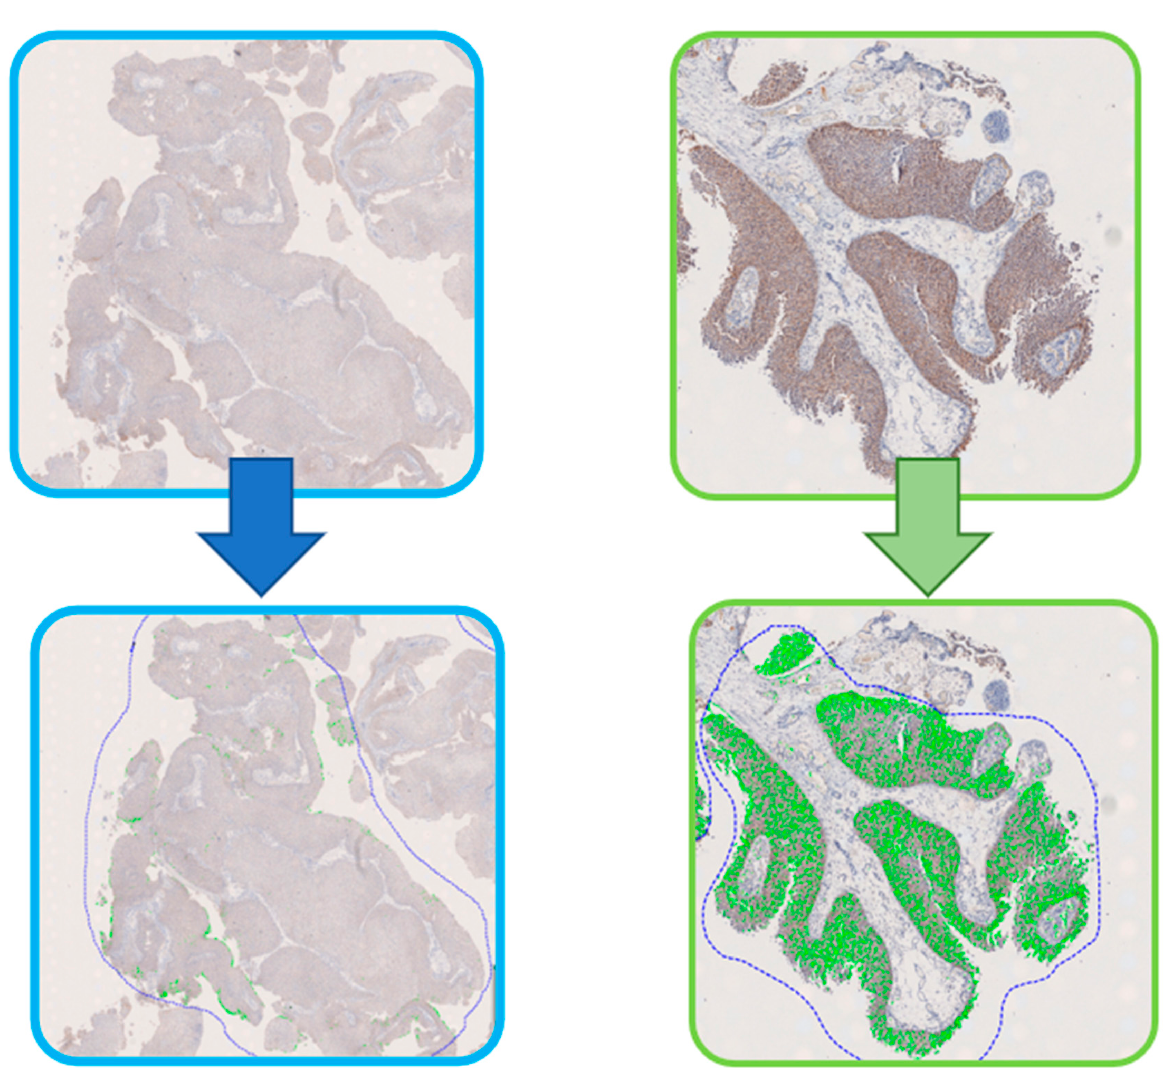
Figure 2. Digital image analysis of HER2-stained BC tissue samples with low ( left ) and high ( right ) protein expression (original magnification 200 ×